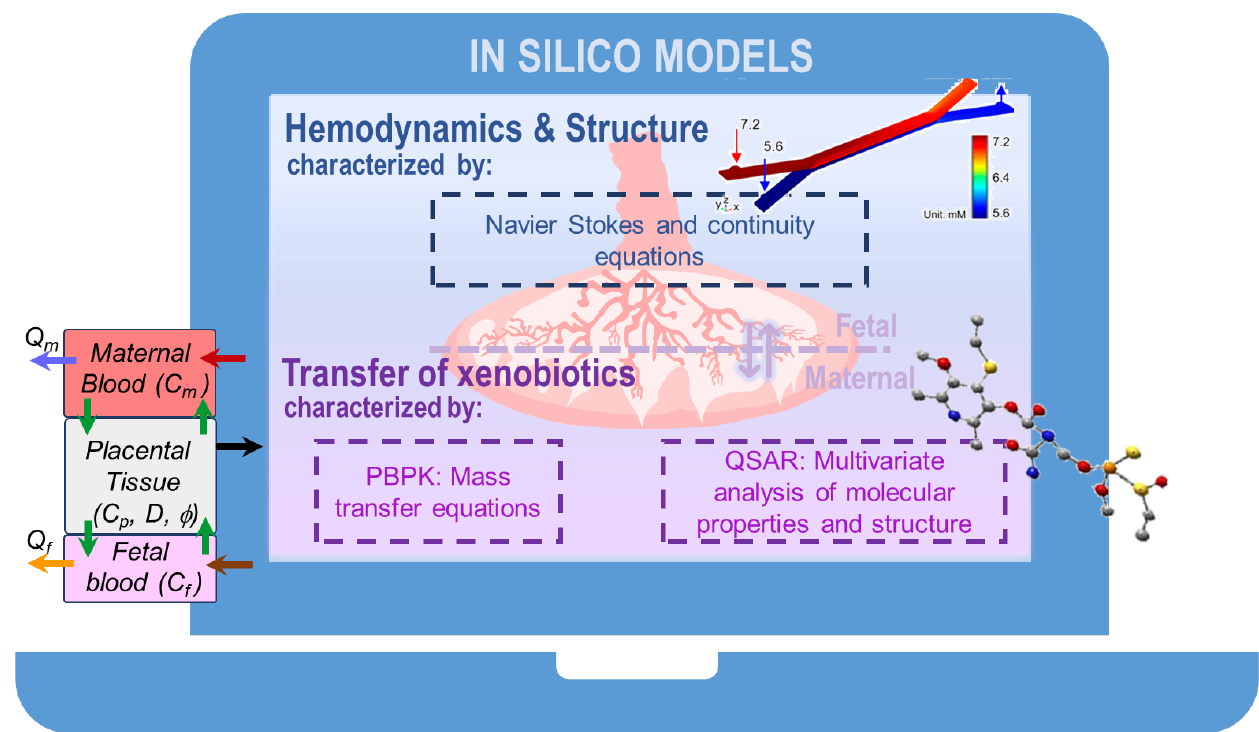
Figure 3. The three primary types of in silico models. Computational fluid and structure interaction models describe the architecture and hemodynamics of the placenta while physiologically based pharmacokinetic (PBPK) and quantitative structure-activity relationship (QSAR) models focus on barrier transport. Blood flow can be characterized by the Navier- Stokes and continuity equations that describe velocity, pressure gradient and blood viscosity [80]. The transfer of substances can be analyzed using a PBPK model that can generically express the change in the concentrations in the placental tissue and fetal compartments ( C p and C f , respectively) according to the concentration in the maternal compartment ( C m ), blood flow rate ( Q ) and the membrane diffusion (D) and partition coefficients ( ϕ ) [81]. QSAR models correlate transfer with physicochemical and structural properties using statistical methods such as multivariate analysis [82].